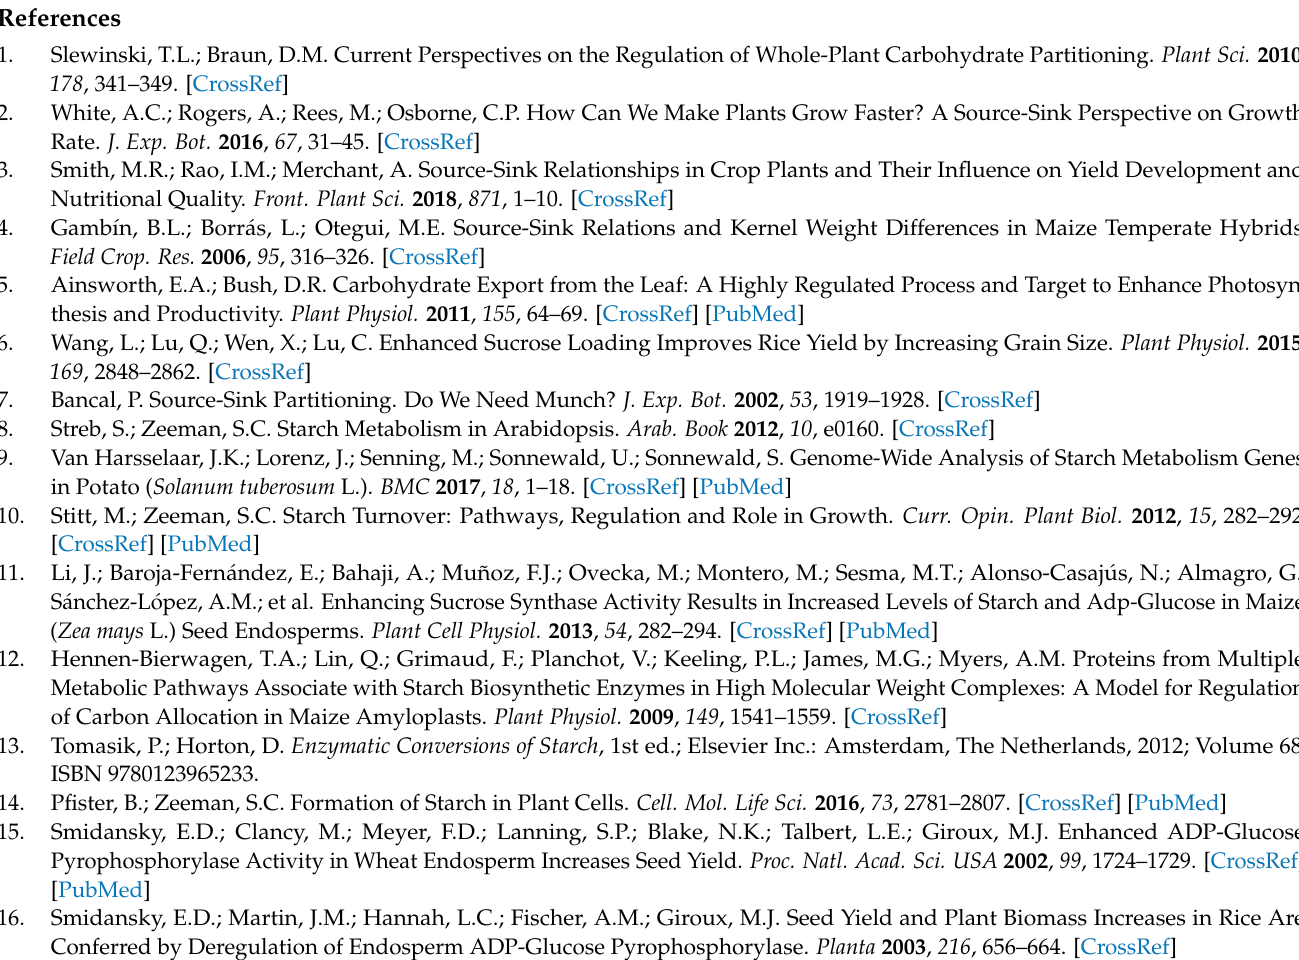
Table S1: Quantitative real-time PCR primers for sucrose-starch genes and transcription factors. Table S2: Differentially expressed genes between female inflorescence (FI) and top internode section of the stem (TI) maize tissues. Table S3: Extended Panther GO enrichment analysis of the DEGs in the female inflorescence (FI) and top internode of the stem